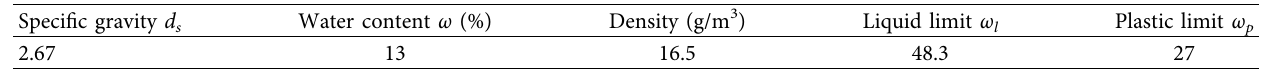
Figure 2: Material diagram: (a) granite residual soil, (b) sodium hydroxide, (c) sodium metasilicate, (d) glass fiber, (e) SH solution. Table 1: Properties of granite soil